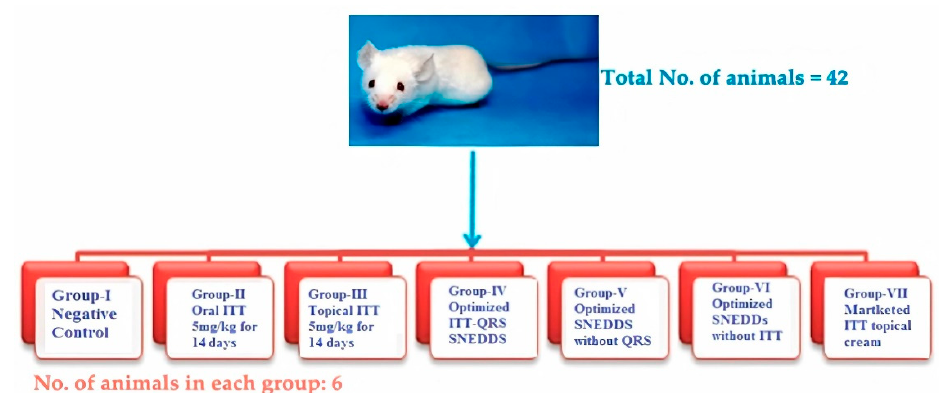
Figure 2. In Vivo animal study groups and sample information.